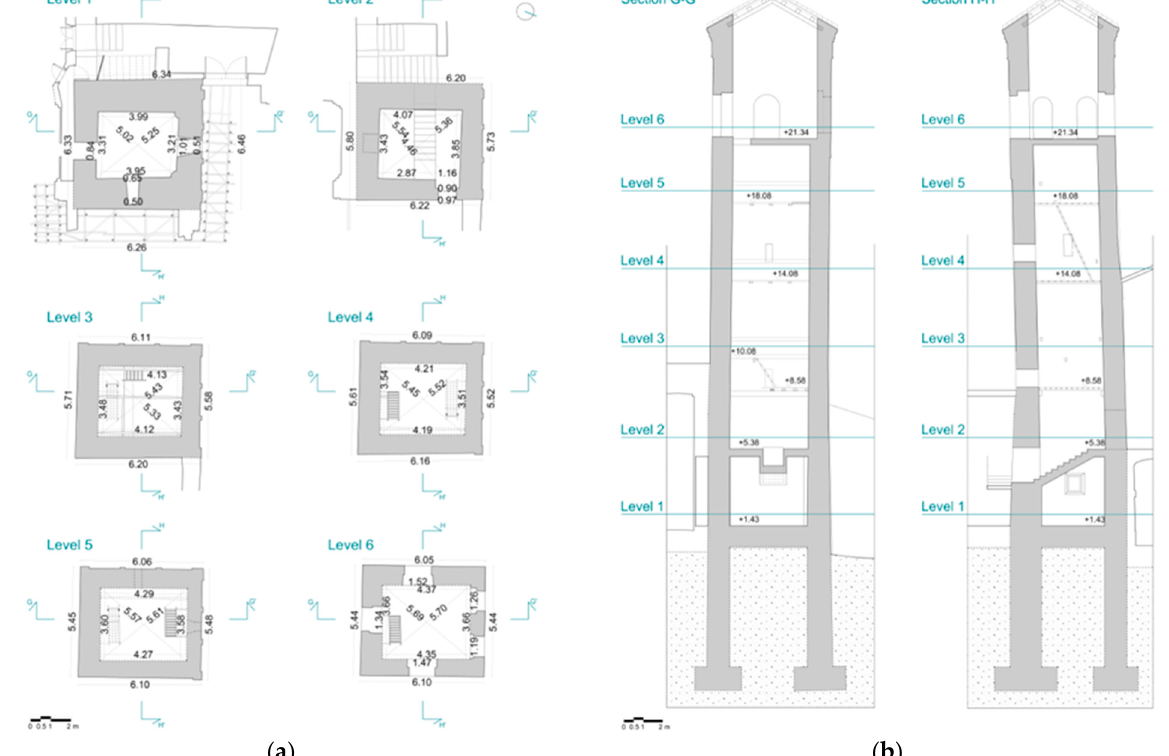
Figure 8. ( a ) Tower plans at different heights and ( b ) vertical sections (geometric survey).